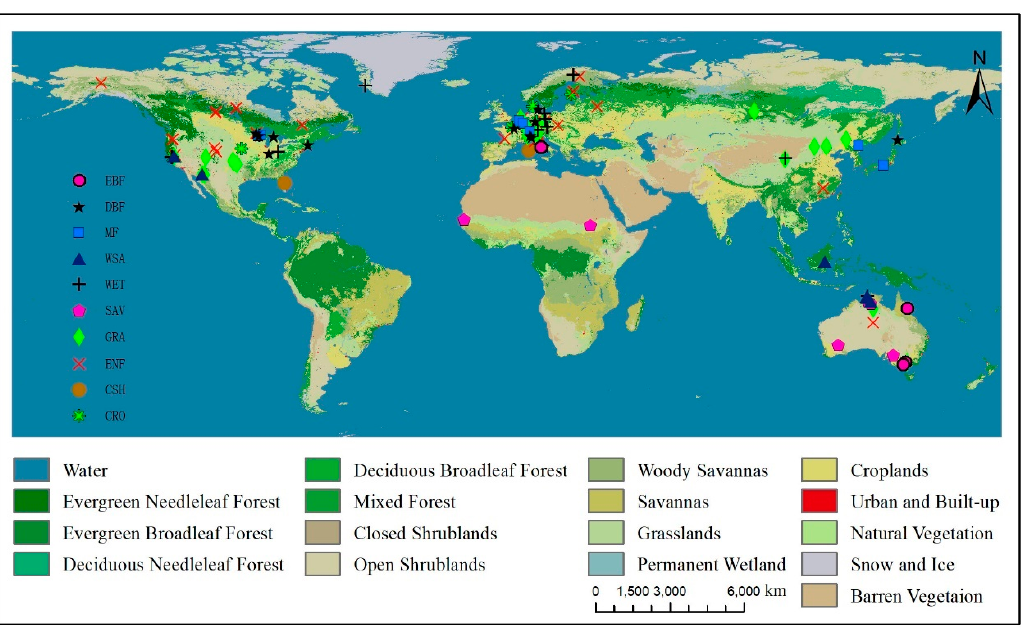
Figure 1. Location and distribution of the 121 eddy covariance (EC) flux sites used in our study. The site description of these FLUXNET sites is provided in Table S1 in the Supplementary Material. The base map is the MODIS land cover map.